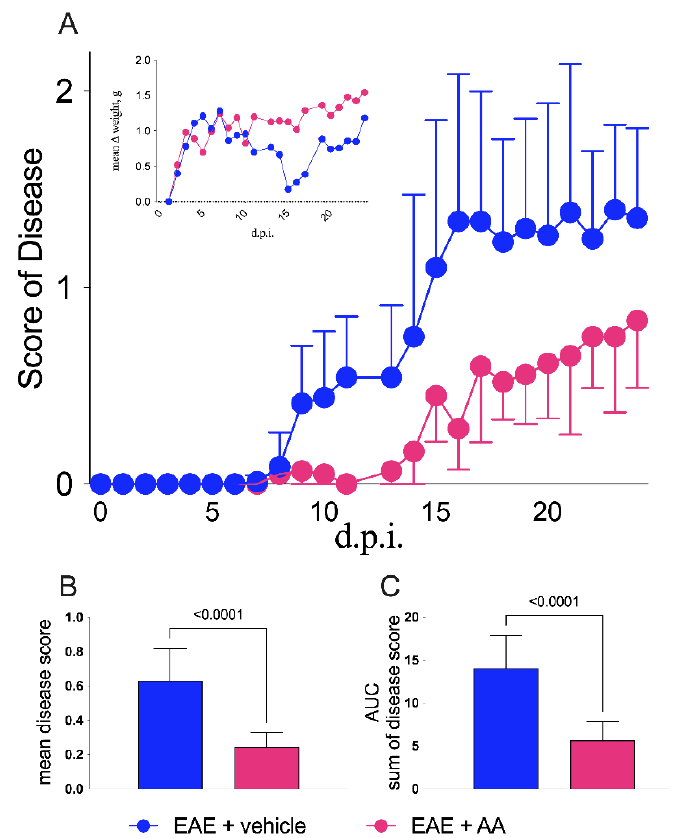
Figure 1. Clinical impact of arundic acid (AA) on experimental autoimmune encephalomyelitis (EAE). ( A ) Mice were monitored daily for clinical staging and sacrificed after 24 days post-immunization (d.p.i.). AA was used in the EAE-affected group (fuchsia line and symbols, n = 15) of mice that received a daily intraperitoneal injection of 4 mg/kg, i.e., 0.08 mL/day from 6 to 17 d.p.i., whereas in the control animal group, saline (PBS) was injected (blue line and symbols, n = 16). Beneficial effects of AA administration were significant from day 10 to day 24 (day 10: p = 0.04; day 11: p = 0.0003; day 13: p = 0.003; day 14: p < 0.0001; day 15: p < 0.0001; day 16: p < 0.0001; day 17 p < 0.0001; day